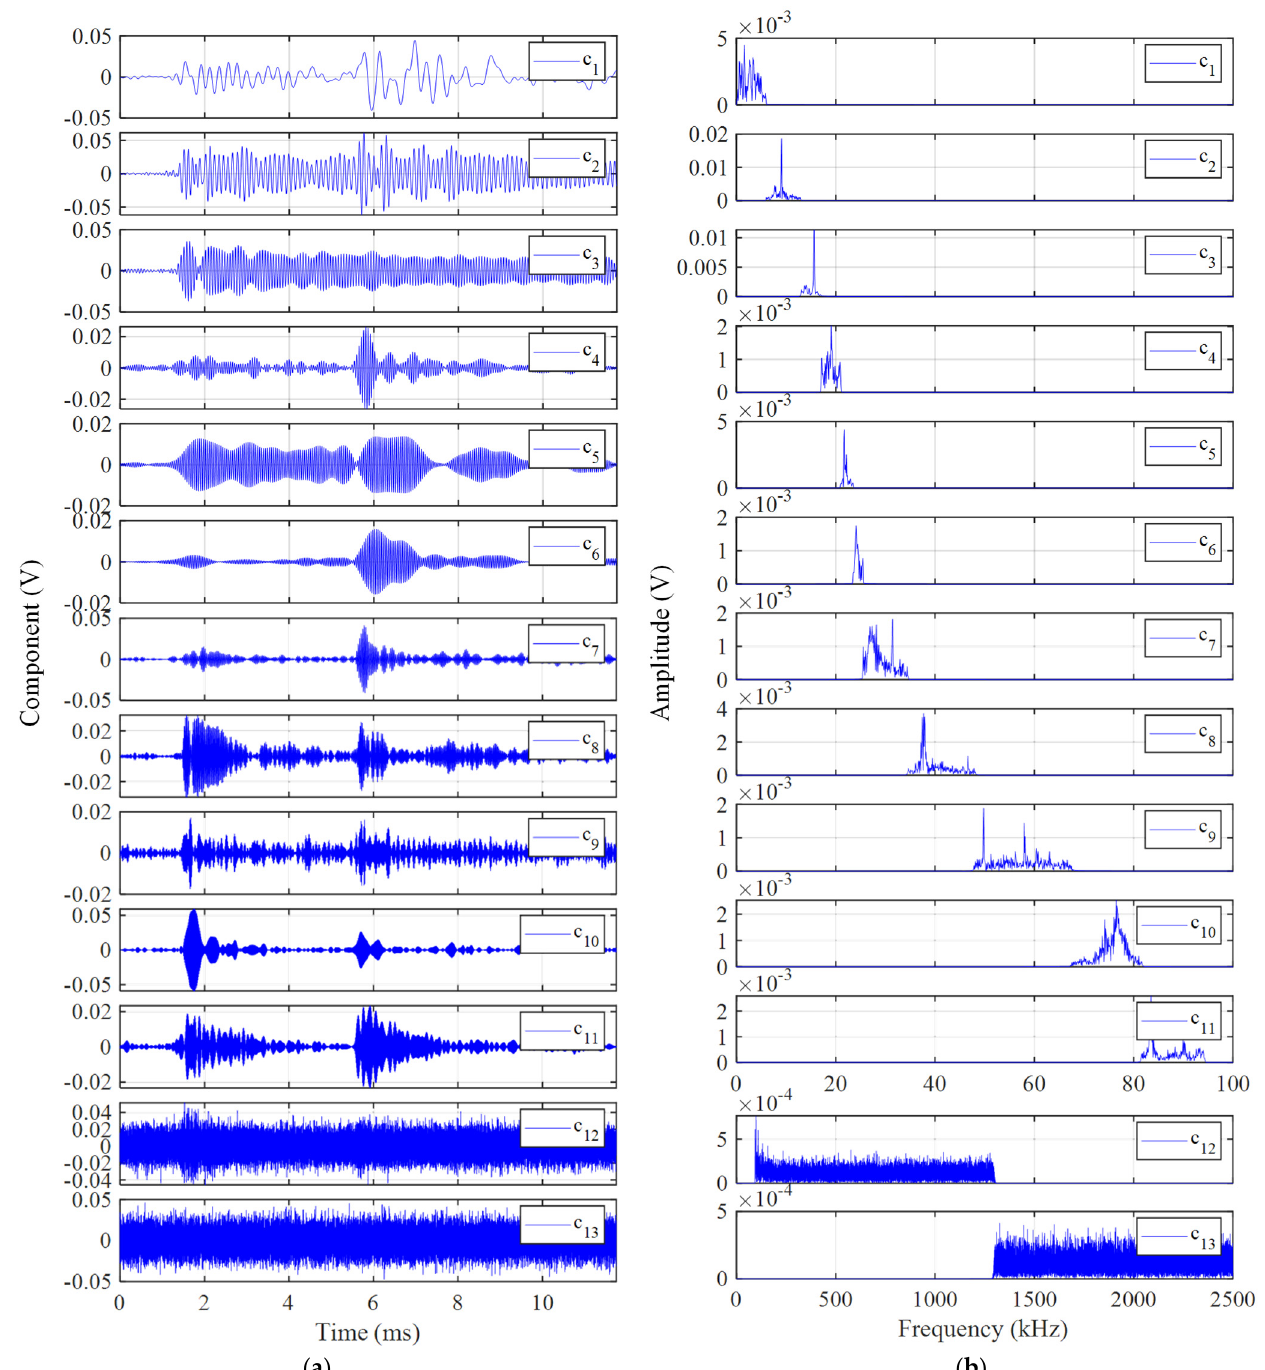
Figure 9. Results of EWT based on STFT and closing operation: ( a ) decomposed components of EMR waveform; ( b ) Fourier spectra of decomposed components.